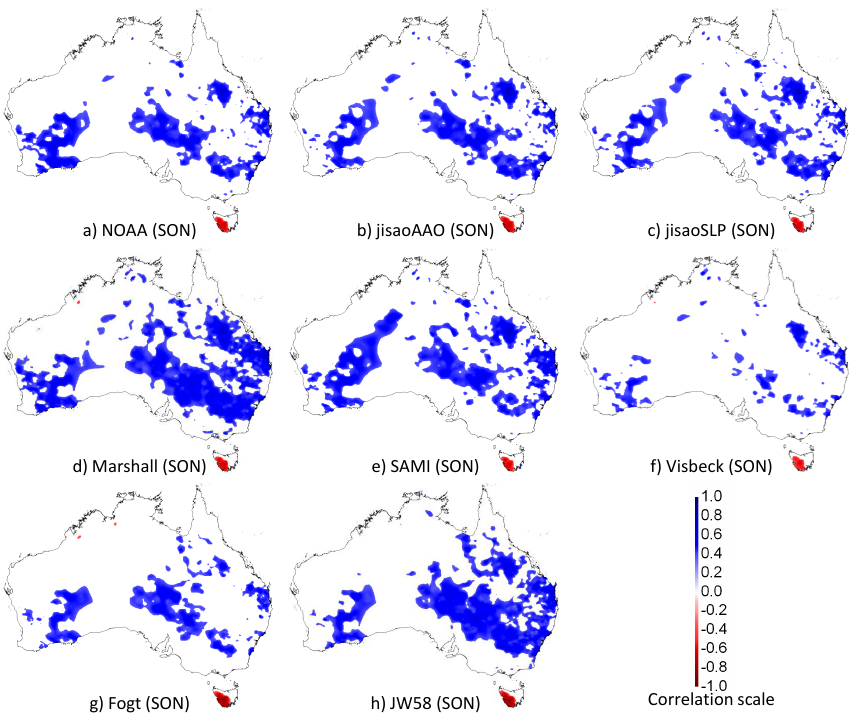
Fig. 7. Correlations between total spring (SON) rainfall and spring SAM indices, 1979–2002 (a) NOAA; (b) jisaoAAO; (c) jisaoSLP; (d) Marshall; (e) SAMI; (f) Visbeck; (g) Fogt and (h) JW58. Note: only correlations that are statistically significant at the 95th percentile are